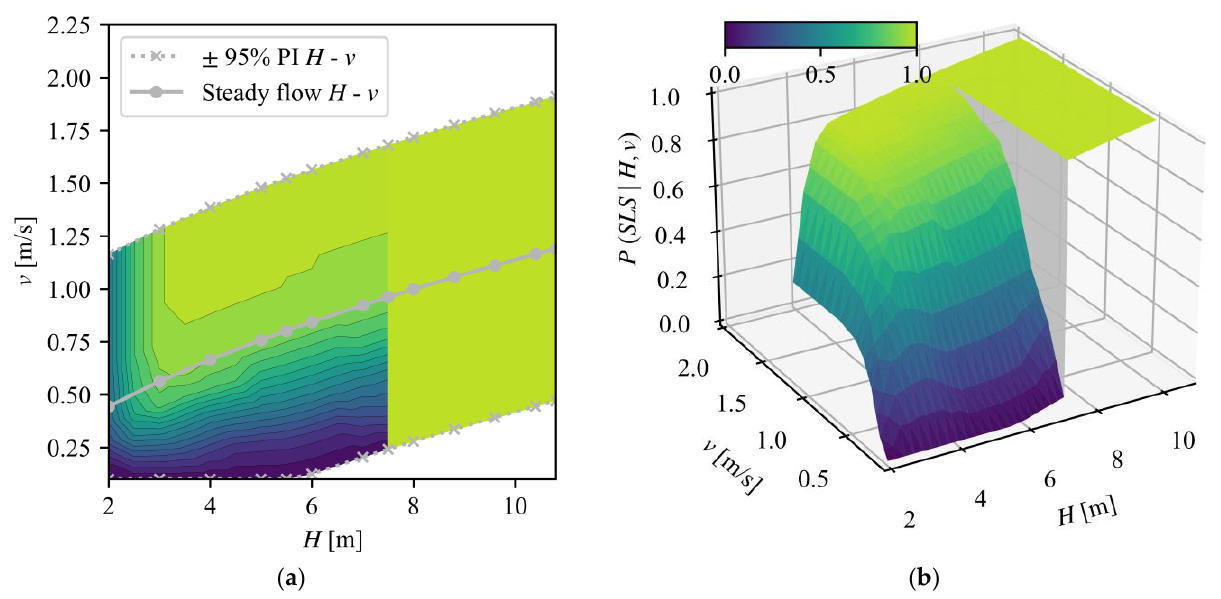
Figure 9. ( a ) Contour and ( b ) 3-D surface plot of the flood fragility surface for the serviceability limit state (SLS) for the second scenario (AS5100.2-2004 standard).